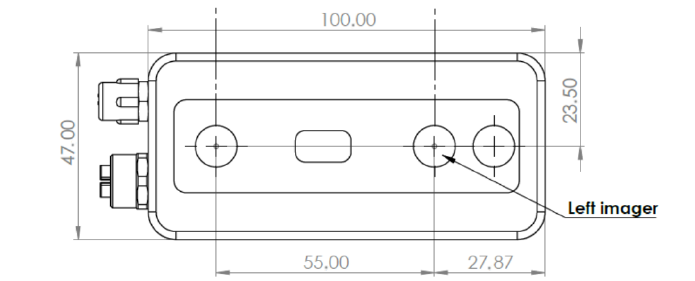
Figure 8. FRAMOS D415e origin reference